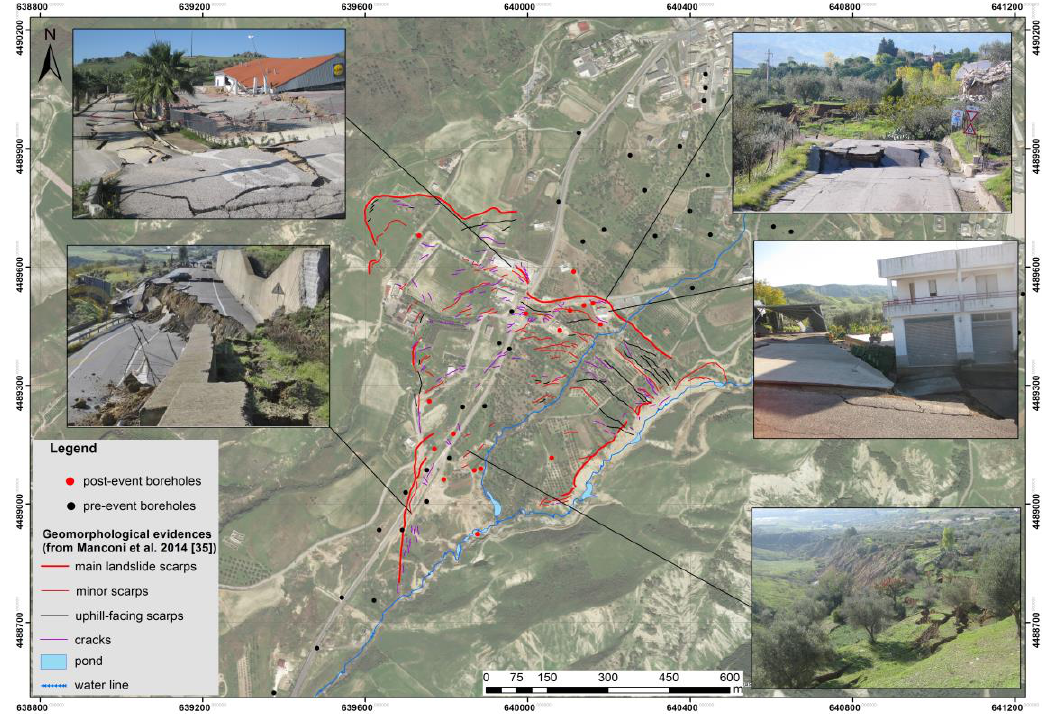
Figure 2. Orthophoto of Montescaglioso area, with the location of the boreholes and main geomorphological features of the landslide. In inserts, photos of the most relevant damages caused by the landslide.